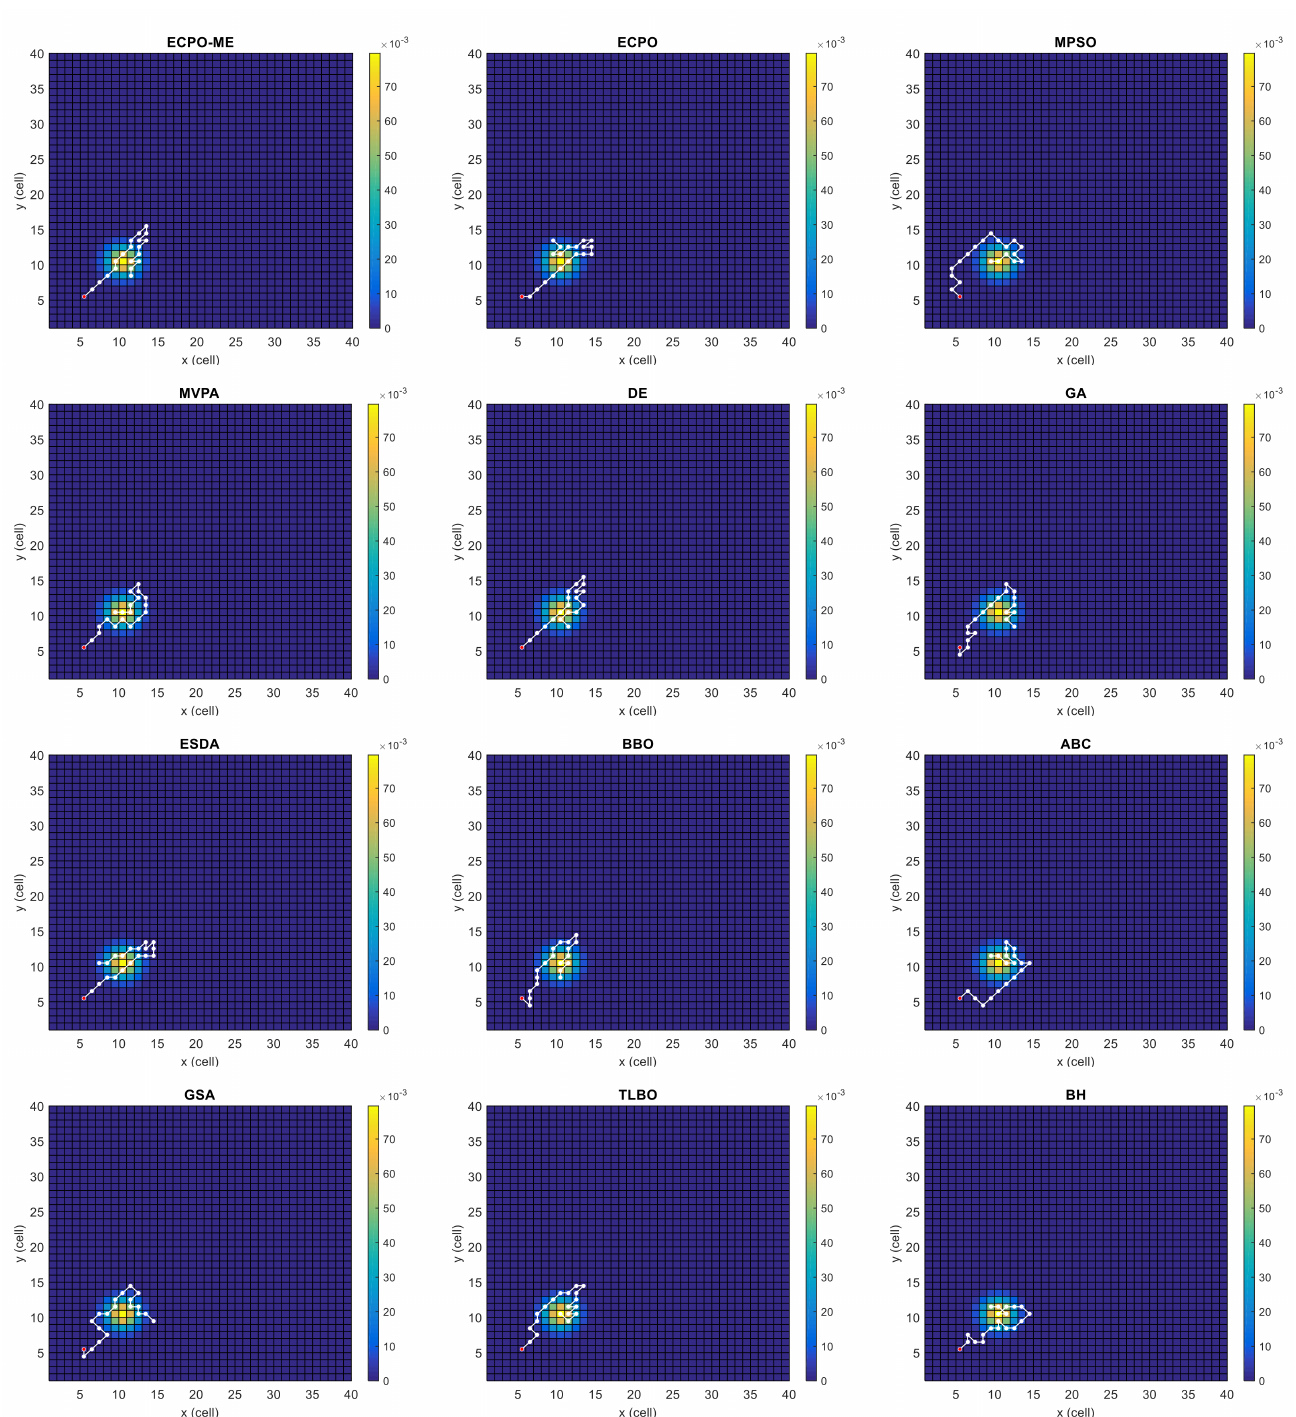
Figure 7. Search paths for Scenario D, obtained using the tested